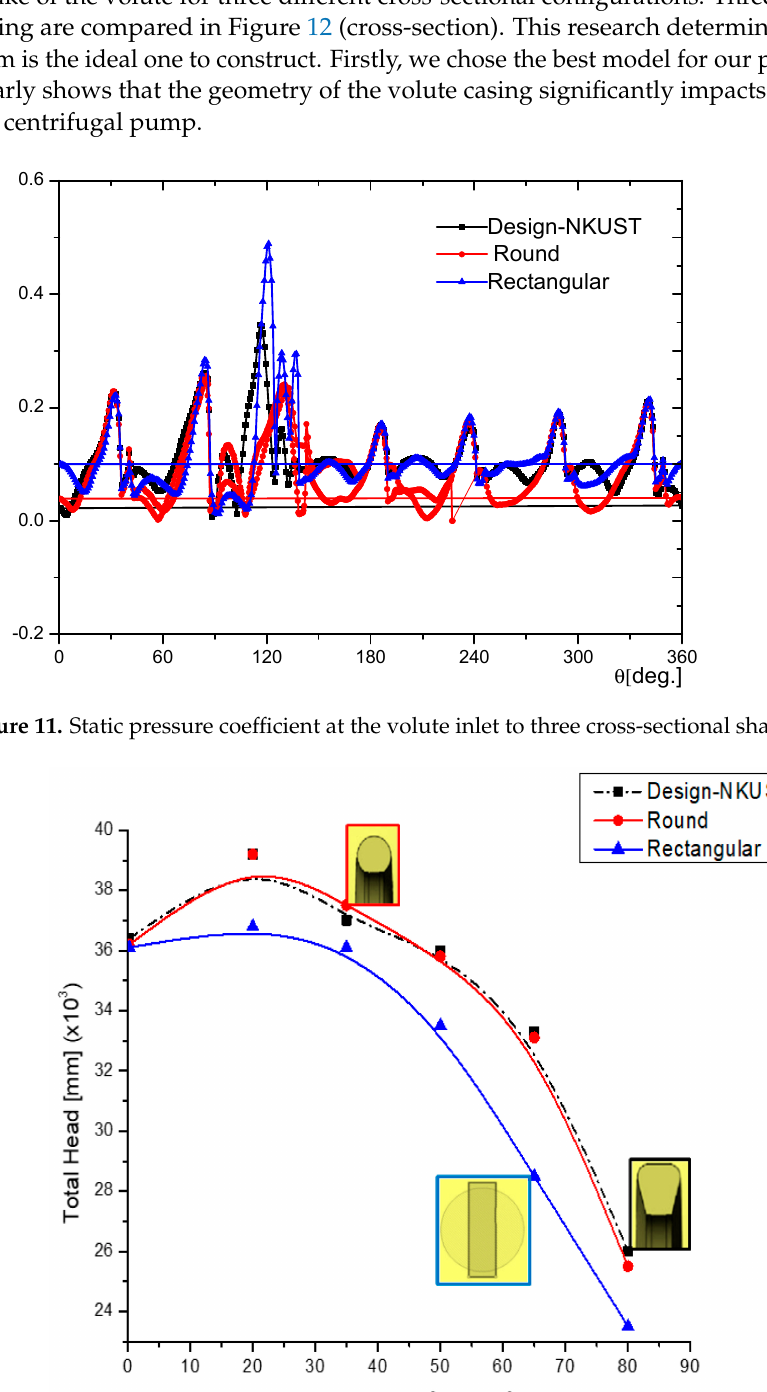
Figure 10. Testing independent mesh in this design.